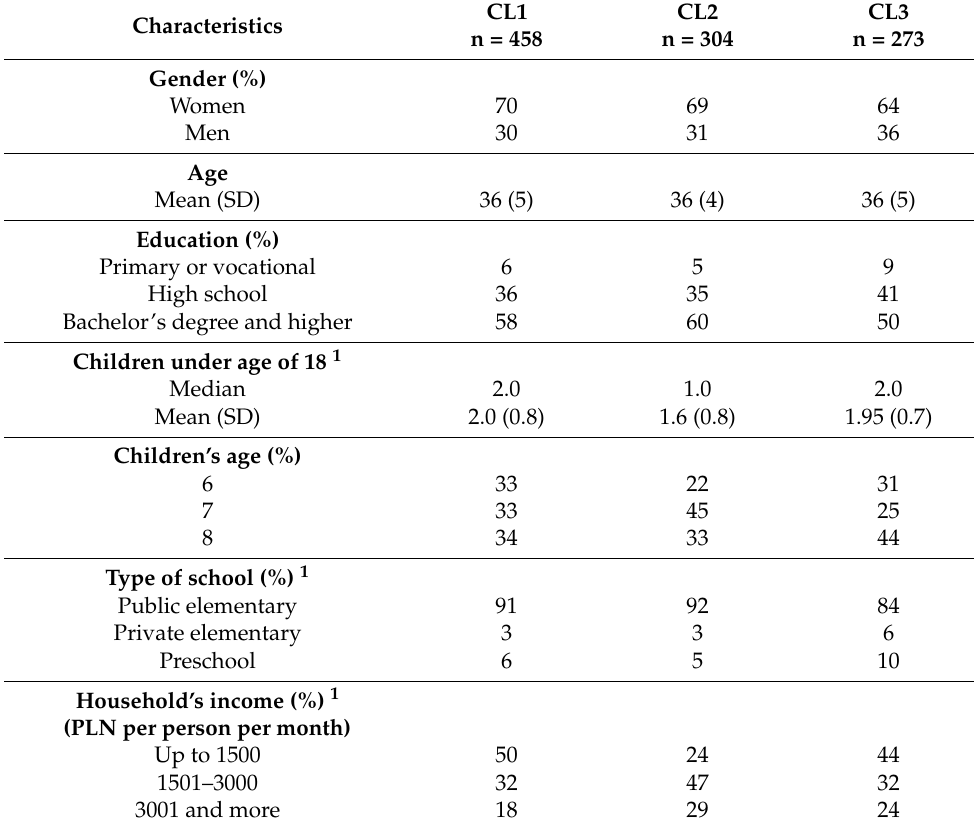
Table 3. Socio-demographic characteristics of the studied sample, by clusters.